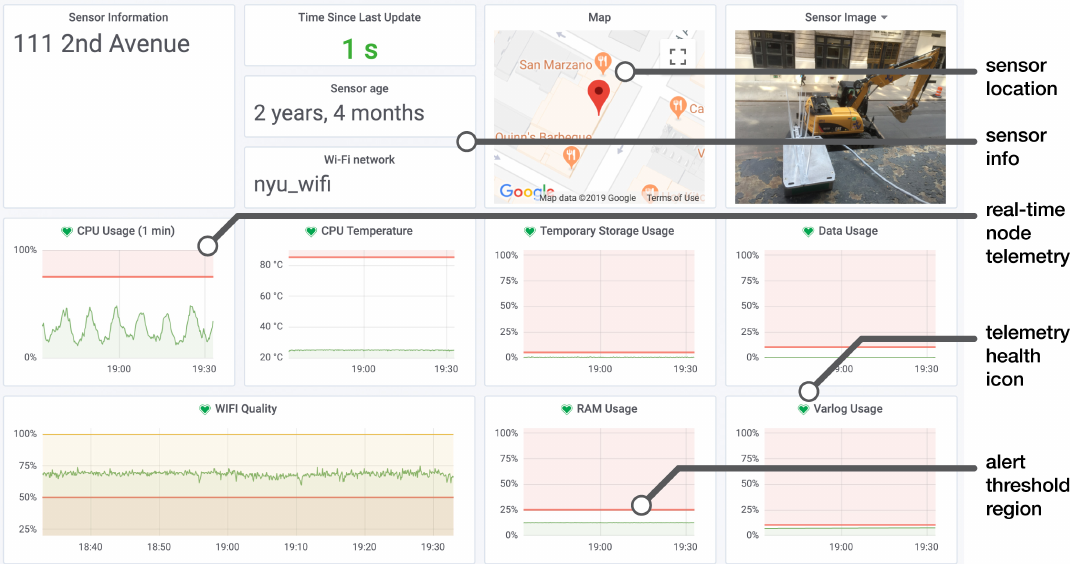
Figure 9. Annotated sensor dashboard showing dedicated real-time sensor